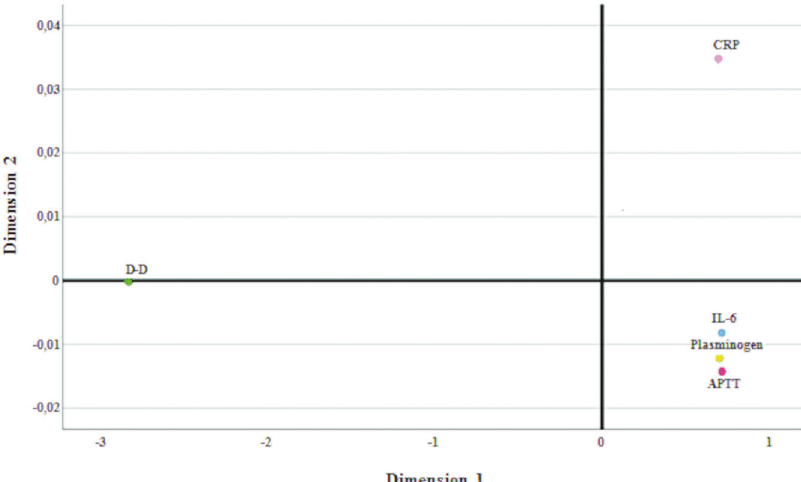
Fig. 2 Multidimensional scaling analysis reporting the correlation of the expression of coagulation and in fl ammatory parameters with plasminogen. IL-6 and APTT tended to cluster together with plasminogen compared to D-dimer and CRP, which tended to be dissociated, and therefore to possibly act independently on different pathways of proin fl ammation. D-D D-dimer, CRP C reactive protein, IL-6 interlukin-6, APTT activated partial thromboplastin